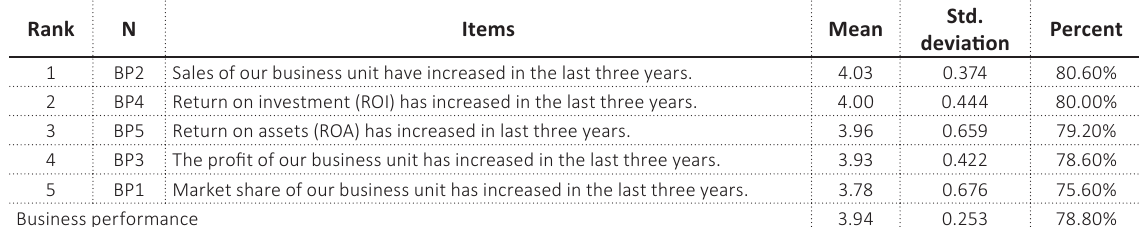
Table 8. Descriptive statistics of business